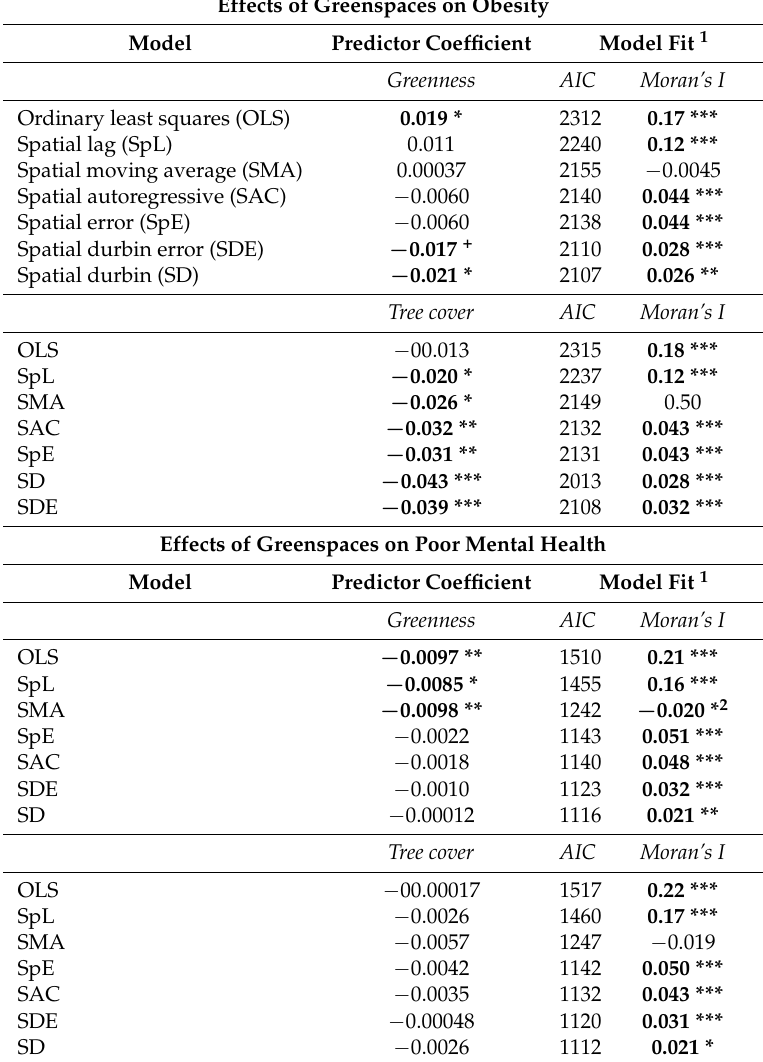
Table A1. Model fits and greenspace—health relationships across regression